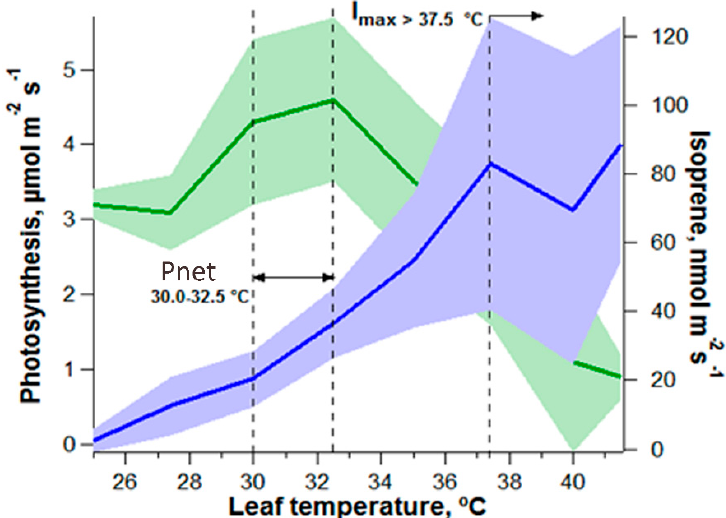
Figure 4. Uncoupling of P net (green) from isoprene emissions (blue) at elevated leaf temperatures as modified from [83] (www.plantphysiol.org, “Copyright American Society of Plant Biologists”). Similar uncoupling of P net and monoterpene emissions at elevated leaf temperatures has also been observed [14]. Vertical dashed line represent optimum temperatures for leaf P net and isoprene emissions (I max ).